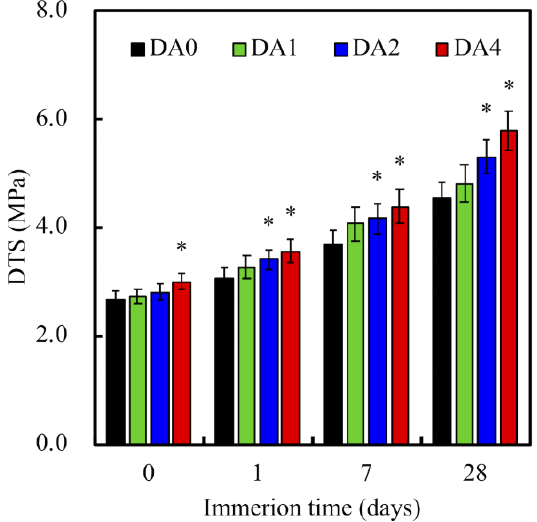
Figure 5. Diametral tensile strength (DTS) of different PDA-coated CS cements, before and after soaking in DMEM. “ * ” indicates a significant difference ( p < 0.05) compared to DA0.